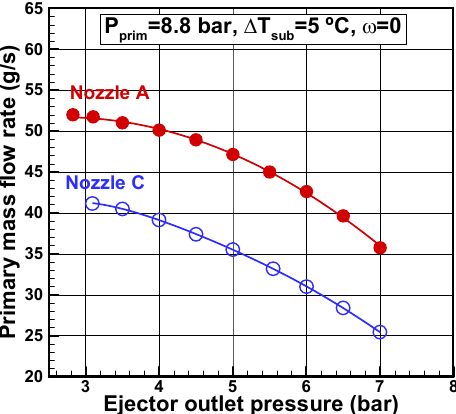
Figure 7. Effects of the throat diameter on the critical mass flow rate.